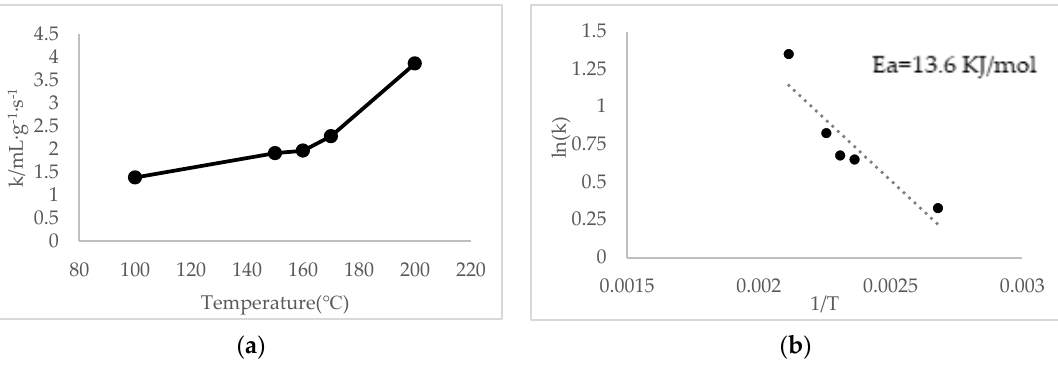
Figure 8. ( a ) Reaction rate coefficient and ( b ) Arrhenius plot of 9MnO 2 –1CeO 2 . Replacing a small fraction of cations in a supporting metal oxide with a different cation served as a useful strategy for improving catalytic activity. To investigate the effect of transition metal doping on lower catalytic temperature, five transition metals (Co, Ni, Fe, Cu, and Cr) were individually loaded on 9MnO 2 –1CeO 2 because of its promising NO oxidation capability and then tested for their catalytic activity based on equimolar oxidation from NO to NO 2 . Metal doping increased low-temperature oxidation activity (Figure 9).